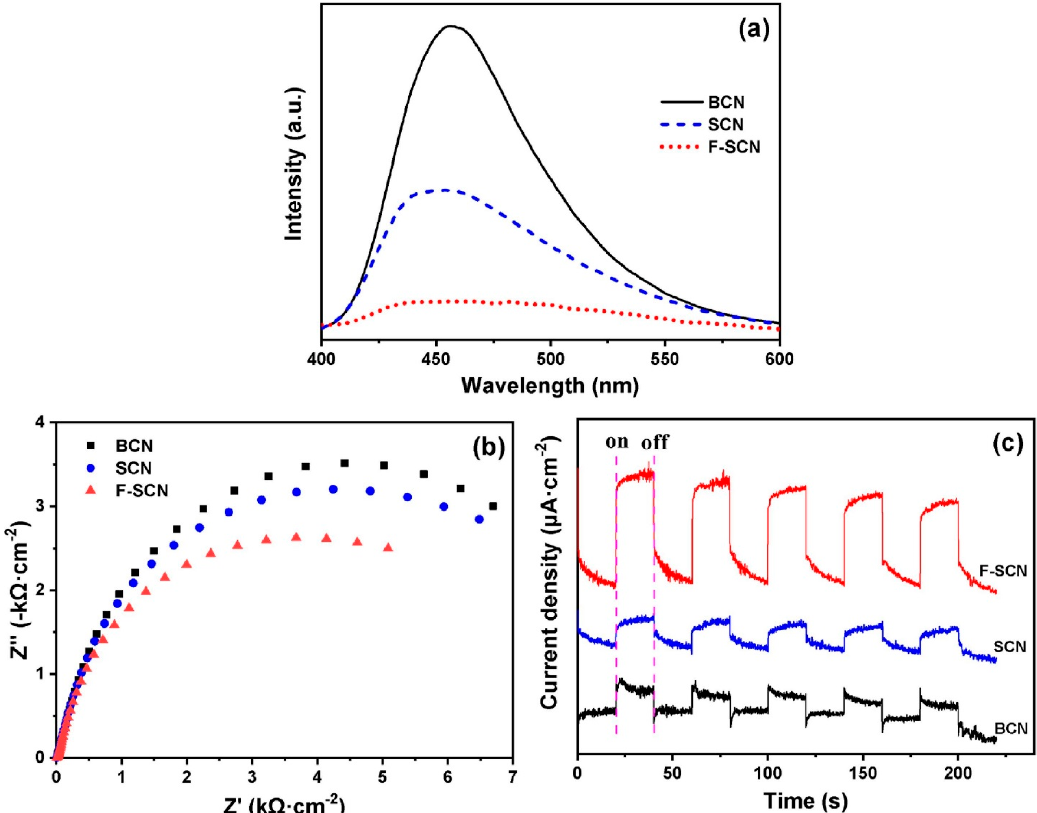
Figure 5. ( a ) PL spectra, ( b ) EIS Nyquist spectra, and ( c ) transient photocurrent response of BCN, SCN, and F-SCN. Reprinted/adapted with permission from [118], 2023, Elsevier (License Number 5507180566714).